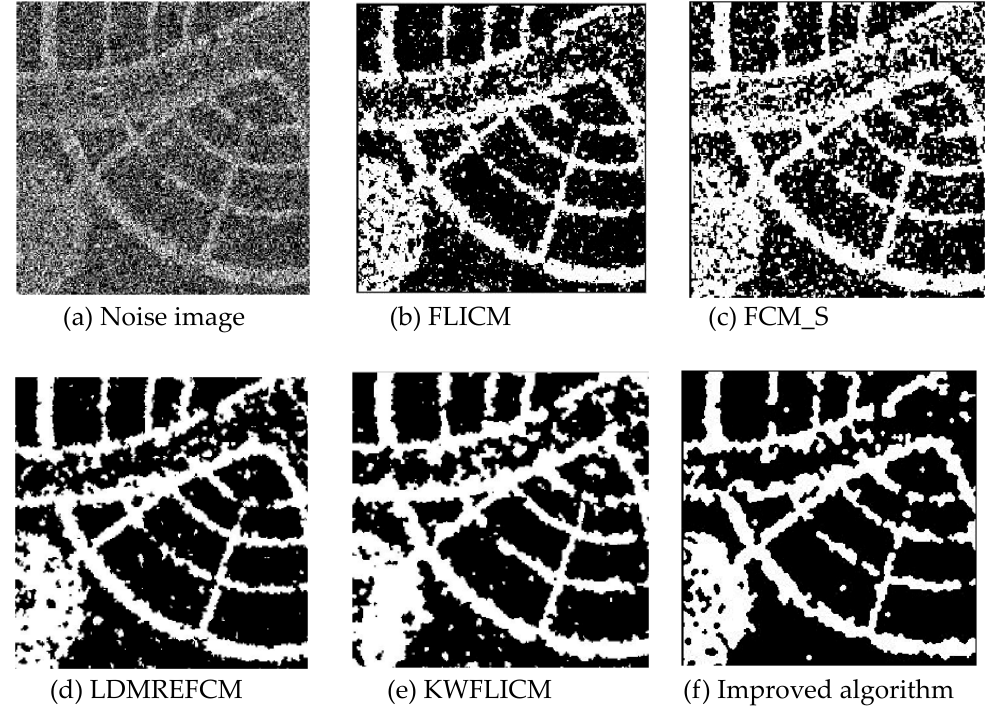
Figure 3. Gaussian noise disturbing remote sensing image 2 ( a ) and the segmentation results ( b – f ).